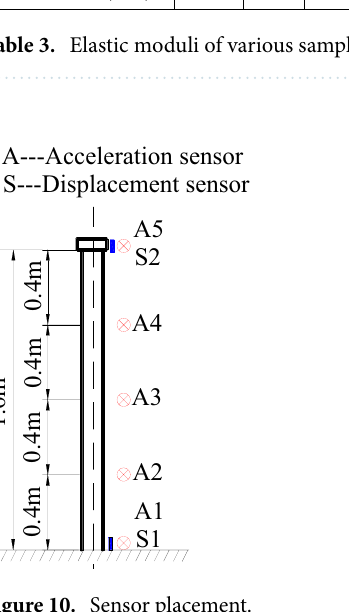
Figure 10. Sensor